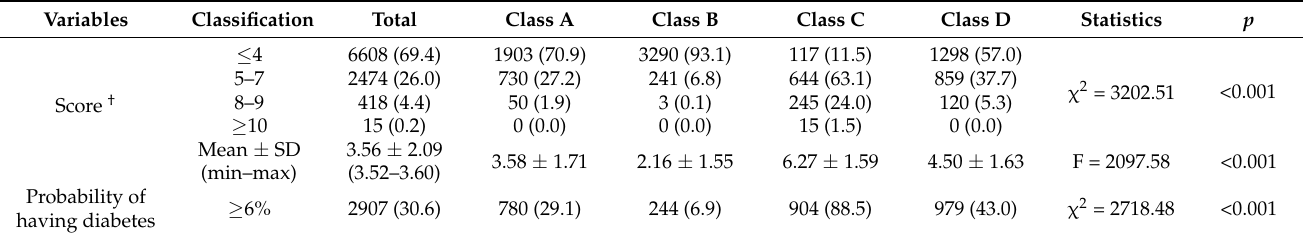
Table 6. Diabetes risk score according to the latent